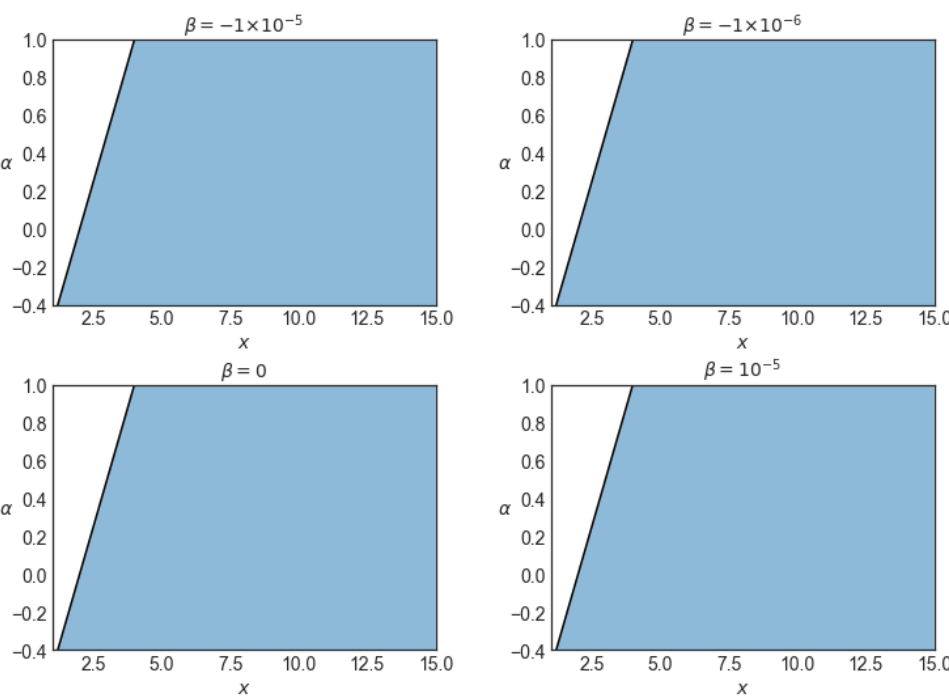
Figure 1. The domain of existence of circular orbits in the equatorial plane, ploted in the ( x , α )-plane. Lightlike orbits are located on the black curve, 2 S − x = 0. Timelike orbits’ positions form the blue area, which is bound by the locus of the null geodesics 2 S − x = 0 and the dashed curve S = 0.